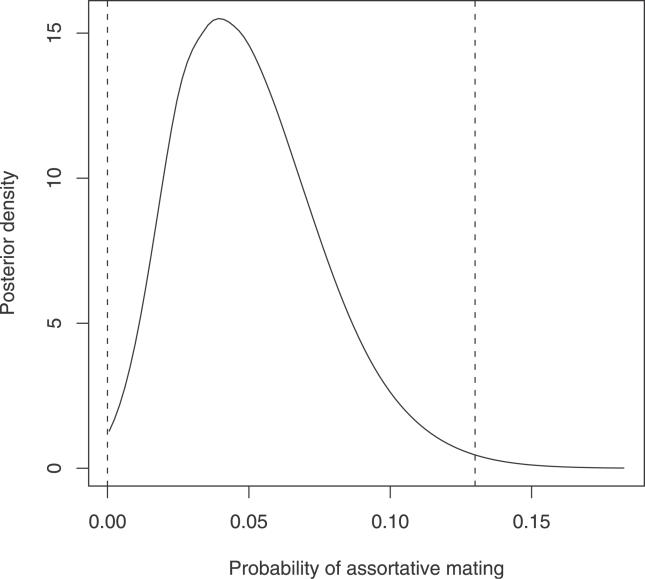
Posterior Density of the Probability of Assortative MatingExperiment 1. Posterior distribution of the probability of assortative mating (
p
Aij) among released
O. nubilalis moths, as estimated using a Bayesian Markov chain Monte Carlo approach (see text for details). The dashed lines indicate the 95% credibility interval (0.00 to 0.13).